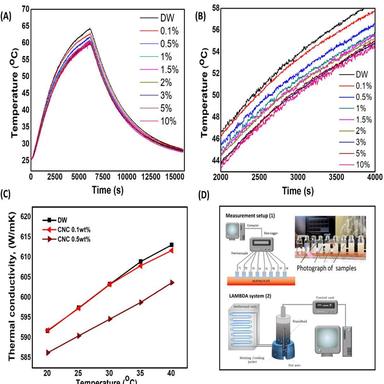
Thermal properties of CNC aqueous solutions with varied concentrations. (A, B) Temperature difference with function of time (C) lambda measurement (D) experimental setup.